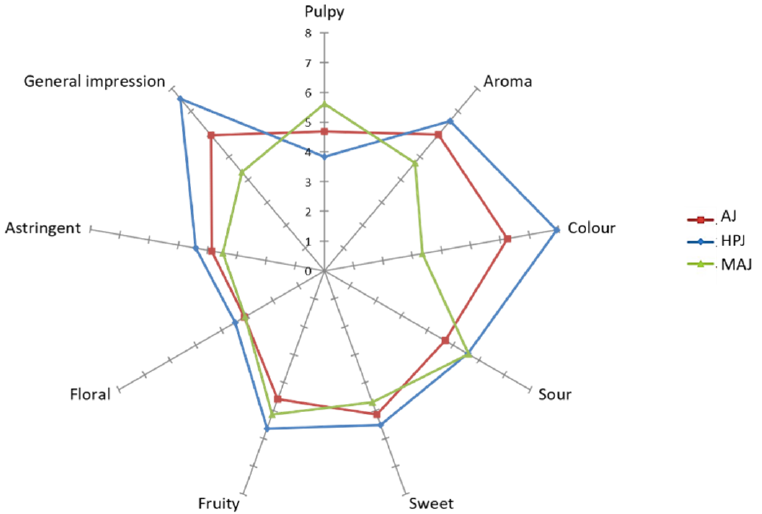
Figure 2. Sensory profiles of pomegranate juice samples. (AJ—Arils juice, HPJ—halved pomegranate juice, MAJ—macerated arils juice).